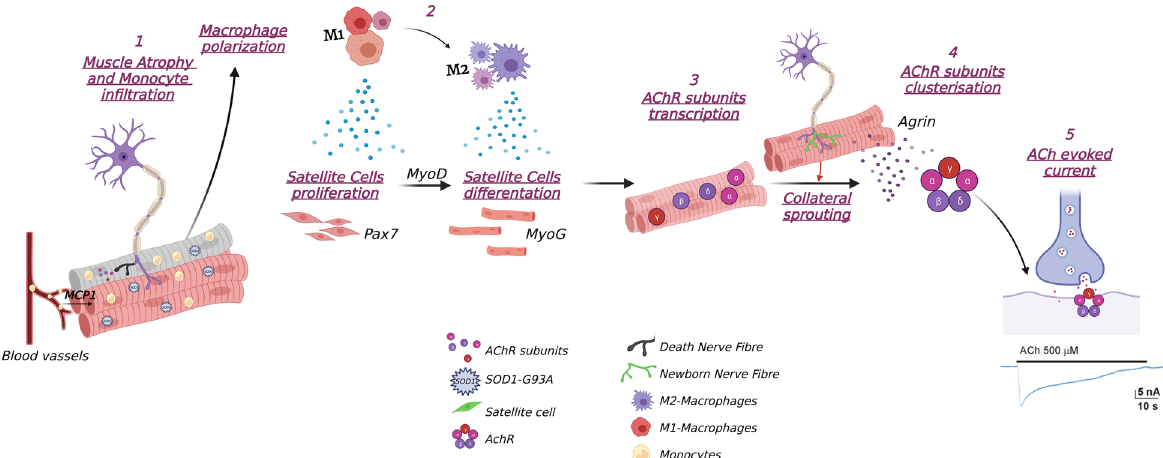
Fig. 9 Candidate cellular mechanisms for motor unit preservation in slow-progressing ALS mice. (1) Muscle denervation induces proinflammatory M Ф (M1) invasion, mediated by chemotactic signals (i.e. MCP1), in the injured tissue area to phagocytise debris and stimulate SC proliferation; (2) the conversion to anti-inflammatory M Ф (M2) (activation Sirt1, AMPK, Arg1) supports the formation and growth of new myofibres; (3) myogenic regulatory factors, MyoG and MyoD, elicit AChR subunits transcription in newly formed and denervated myofibres; (4) AChR clusterisation is induced by muscle reinnervation (collateral sprouting), which occurs at both denervated and newly formed synapses; (5) the evoked response to released ACh is enhanced leading to the maintenance of motor unit function despite muscle atrophy. The lack of M1-M2 polarisation in fast-progressing ALS mice prevents myogenesis and reinnervation upon muscle denervation. Created with BioRe nder.